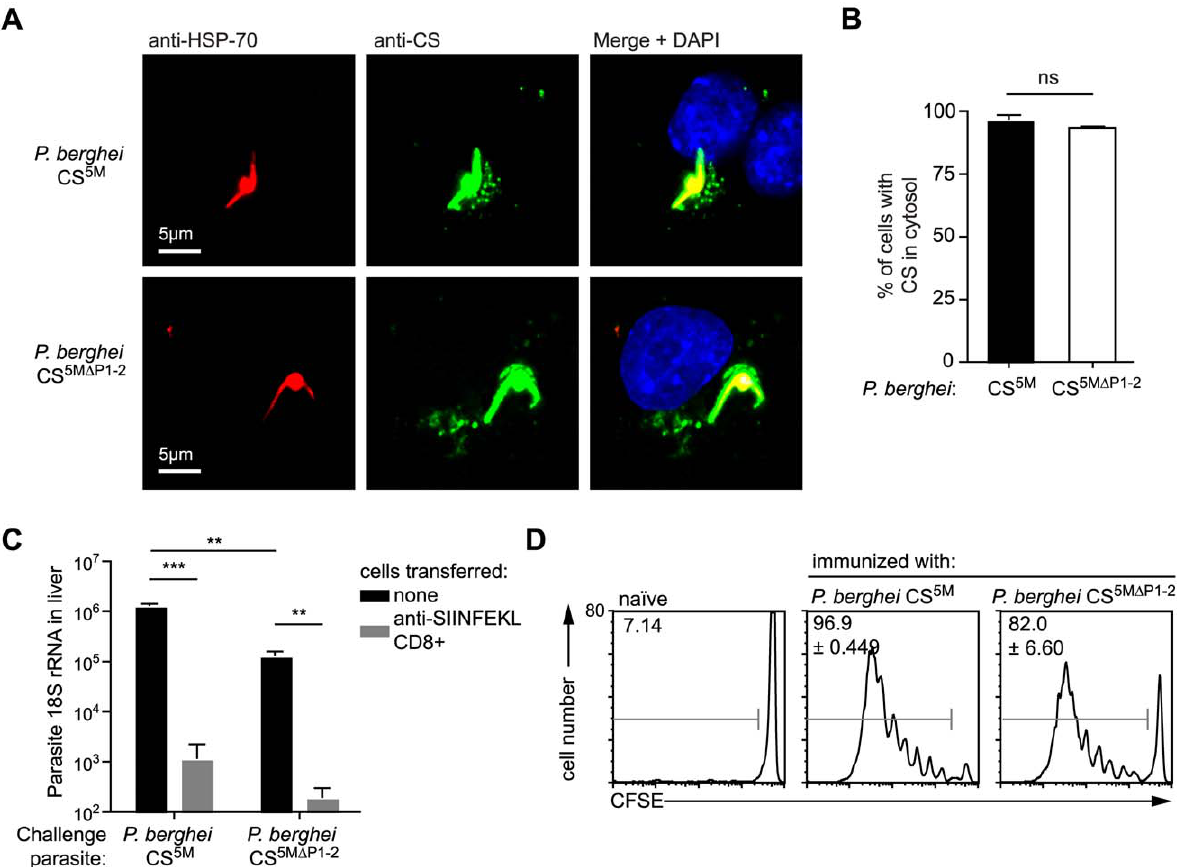
Figure 6. Pexel/VTS motifs are not required for the presentation of CD8 + epitopes in the CS protein. A. Fluorescence microscopy of Hepa1–6 cells 6 hours after infection with P. berghei CS 5M and P. berghei CS5M D P1–2 . Parasites were visualized by staining with anti- Plasmodium HSP70 (red) and the localization of the CS protein determined by staining with the 3D11 mAb (green). B. % of parasites with CS visible in the host cell based on microscopy performed as in A, (mean 6 SEM; data are based on 3 independent experiments per parasite strain with 50 parasites imaged per experiment). C. C57Bl/6 mice received 2 6 10 6 SIINFEKL specific effector CD8 + T cells 3 hours prior to challenge with 5 6 10 3 P. berghei CS 5M or P. berghei CS 5M D P1–2 sporozoites (grey bars); control mice did not receive effector cells (black bars). 40 hours later livers were taken and parasite rRNA concentration determined by real-time PCR (mean 6 SEM; n=4, data from one of 2 similar experiments). D. C57Bl/6 mice received 5 6 10 5 CFSE labeled naı¨ve SIINFEKL-specific cells one day prior to immunization i.d. with 5 6 10 4 P. berghei CS 5M or P. berghei CS 5M D P1–2 parasites in the right ear. Three days later the mice were sacrificed and ear draining lymph nodes taken. Antigen presentation in vivo was inferred by determining the % of SIINFEKL-specific cells that had proliferated (mean 6 SEM; n=3, data representative of 2 similar